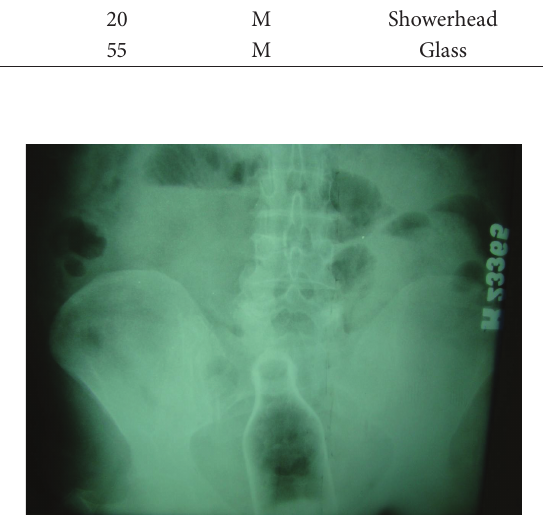
Figure 1: X-rays revealed a bottle visualized in the rectosigmoid area.